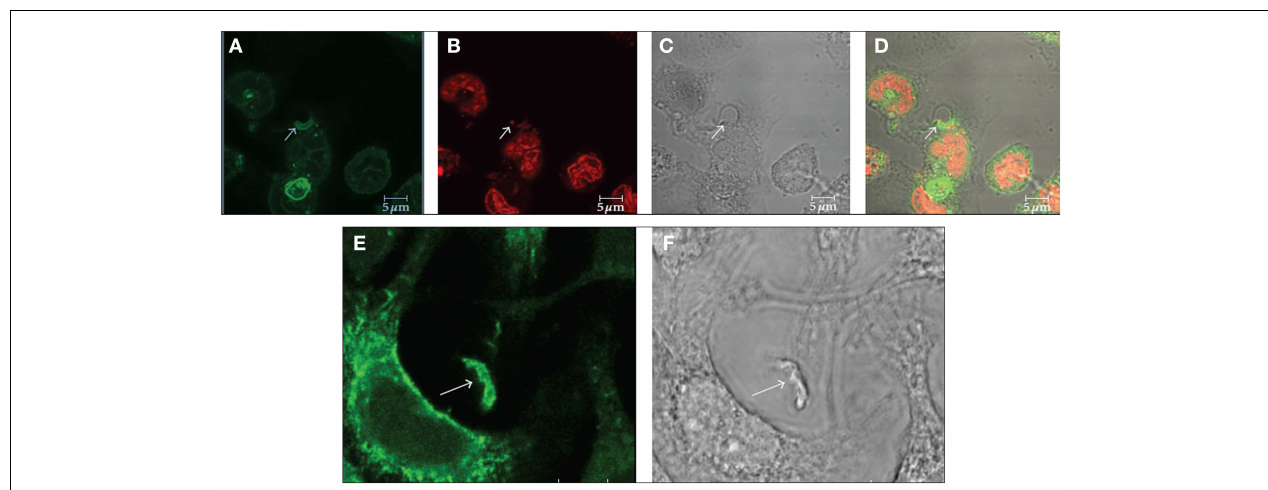
intracellular parasite (C : arrow). (B) Shows labeling of the nucleus and kinetoplast with propidium iodide. Corresponds to a DIC image; (D) is a merge image. (E,F) Co-localization of flotillin 1 (A) , detected using a specific antibody, and trypomastigotes (B : arrows). Bars – 5 µ m. After Ref. (57).